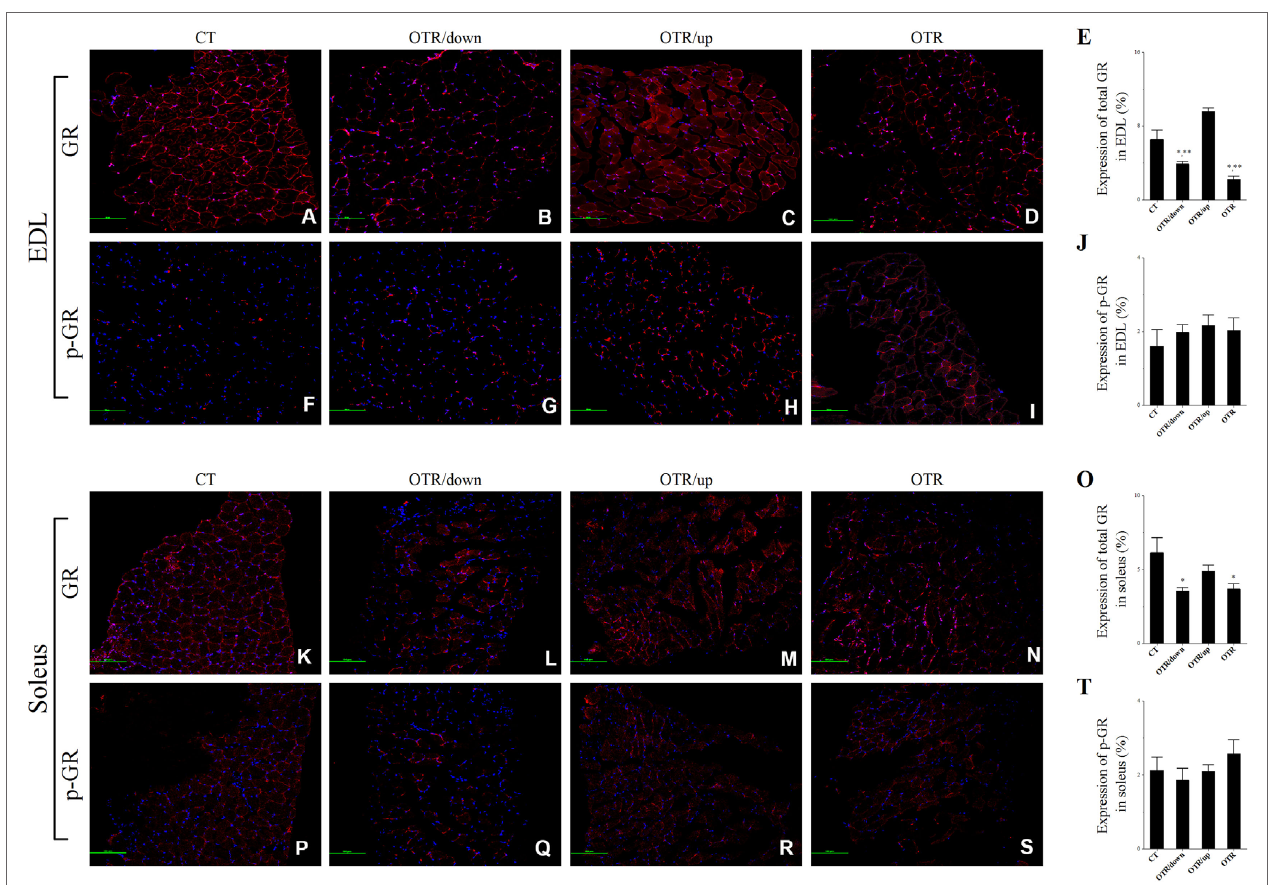
FigUre 7 | Representative immunofluorescence images of total and phosphorylated glucocorticoid receptor (GR) expressions in extensor digitorum longus (EDL) and soleus from control (CT) (a,F,K,P) , downhill running-based overtraining (OTR/down) (B,g,l,Q) , OTR/up (c,h,M,r) , and OTR (D,i,n,s) . Percentage of total and phosphorylated GR expressions in EDL (e,J) and soleus (O,T) muscles. Data correspond to n = 4 mice. CT: sedentary mice. OTR/down: overtrained by downhill running. OTR/up: overtrained by uphill running. OTR: overtrained by running without inclination. * P < 0.05 vs. CT; ** P < 0.05 vs.